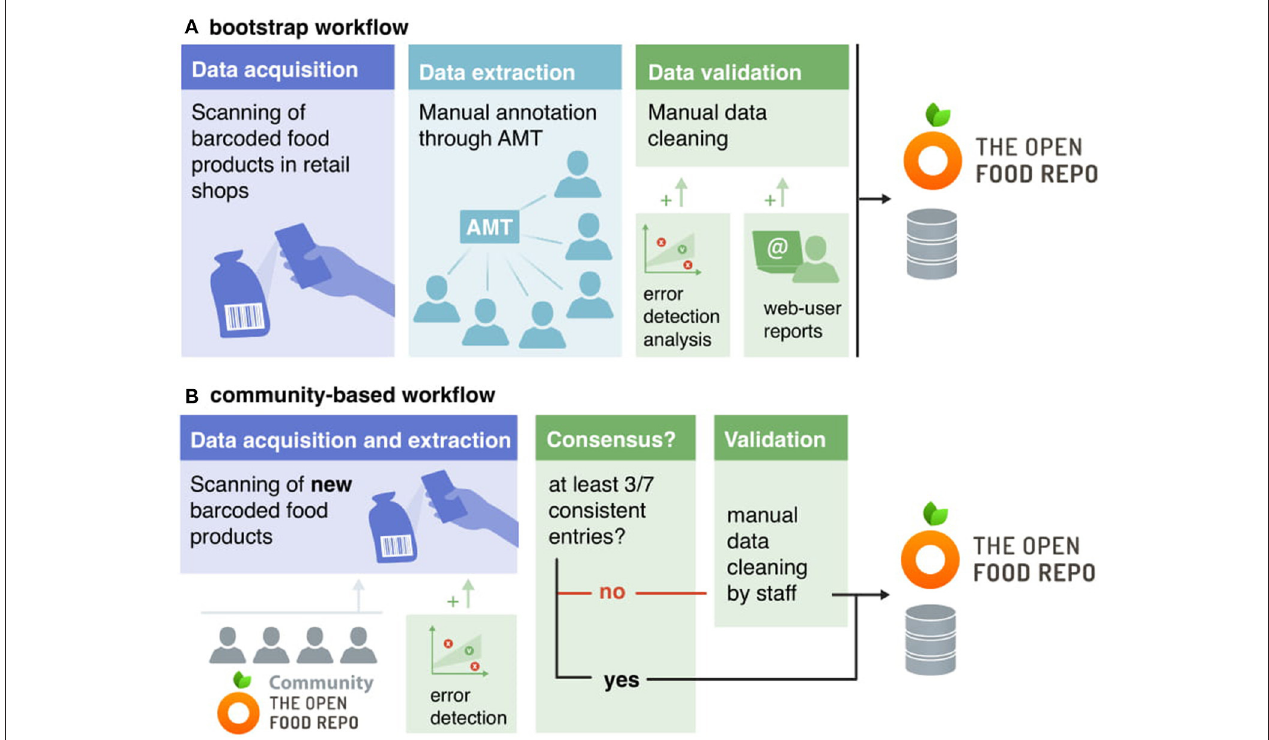
FIGURE 2 | Schematic overview of FoodRepo data collection and validation processes. The two workflows are illustrated here. The bootstrap workflow (A) was based on the joint work of the FoodRepo team and crowd-sourced workers collecting and validating the data. This allowed the storage of the first 14,000 or so products in the database. The community-based workflow (B) allows for long-term sustainability of the database thanks to customers uploading new products through FoodRepo mobile app and the continuous support of the FoodRepo